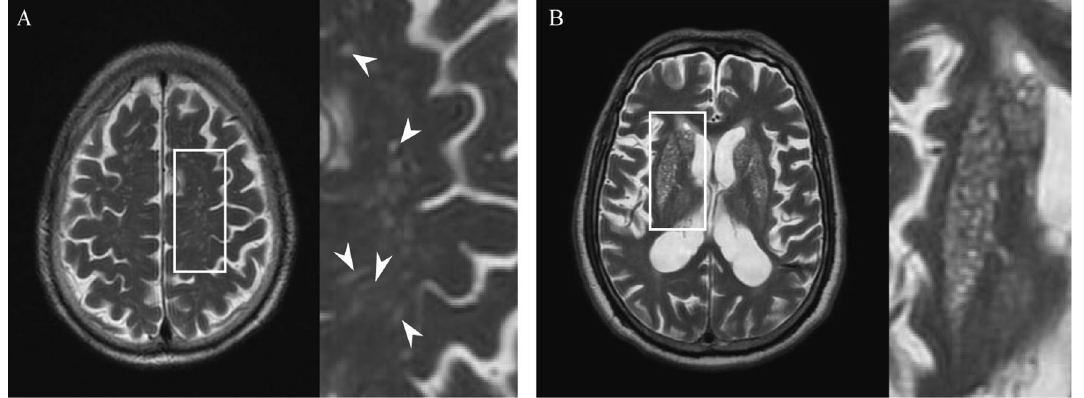
Figure 2. Representative examples of high degree of CS-EPVS ( A ) and BG-EPVS ( B ). Arrowheads point to individual EPVS. EPVS enlarged perivascular spaces, BG basal ganglia, CS centrum